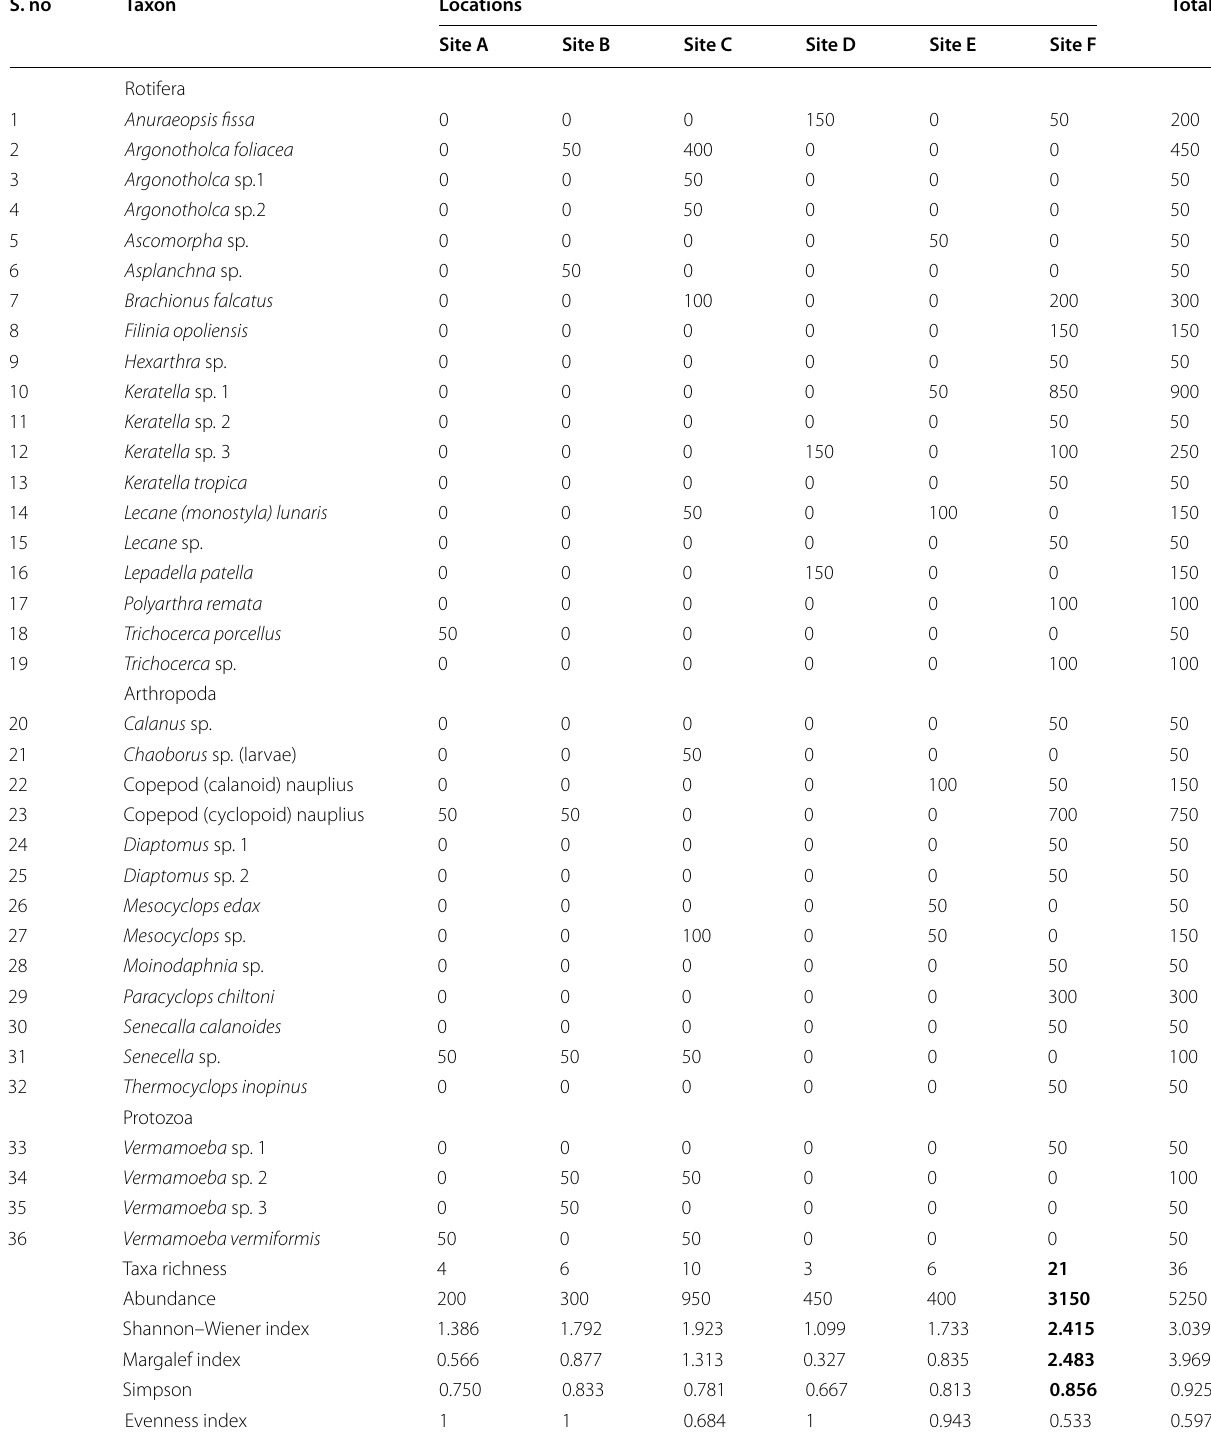
The bold values represent the highest level of the determined parameter in